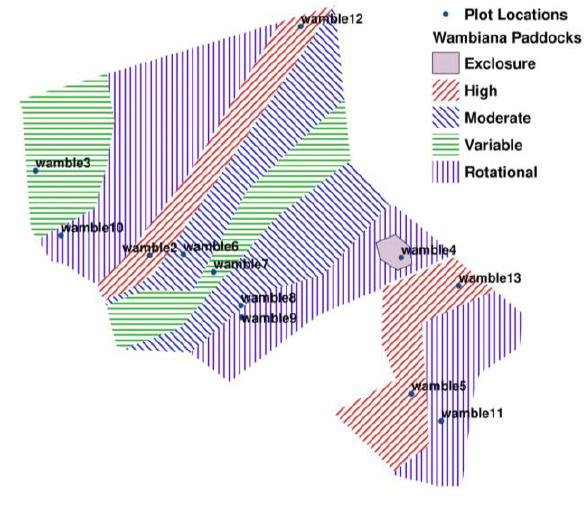
Figure 2. Location of field plots within the Wambiana grazing trials and associated treatment type